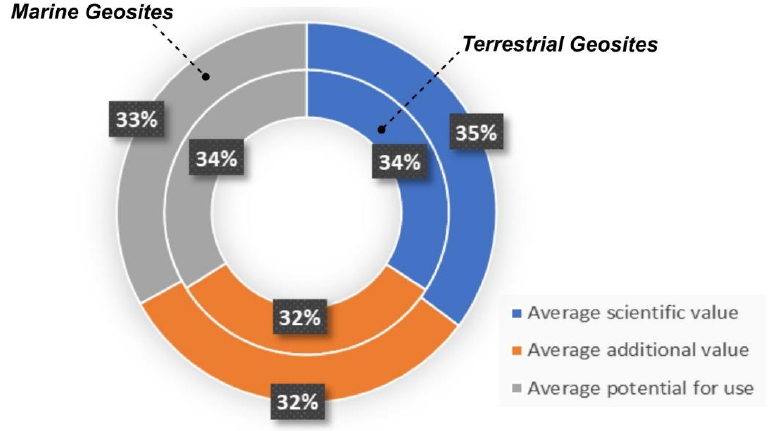
Figure 5. Compared graphs referring to the average of the scientific, additional, and potential for use total values (cf. Section 4.2), calculated considering all the assessed terrestrial (inner circle) and marine geosites (outer circle), respectively.